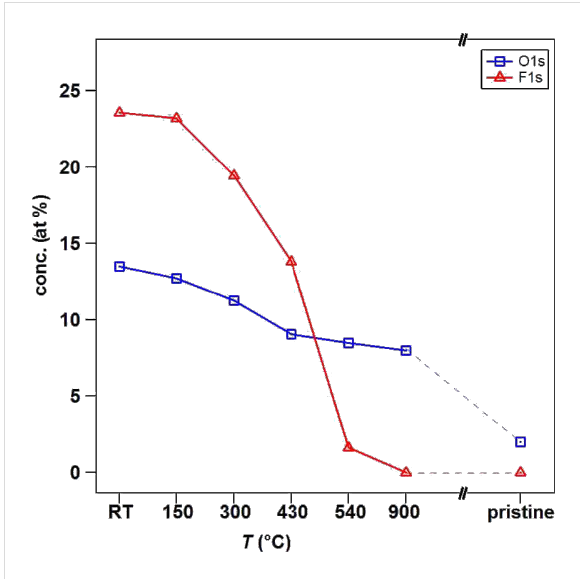
Figure 2: Atomic concentration of oxygen (blue squares) and fluorine (red triangles) calculated from XPS analysis as a function of heating